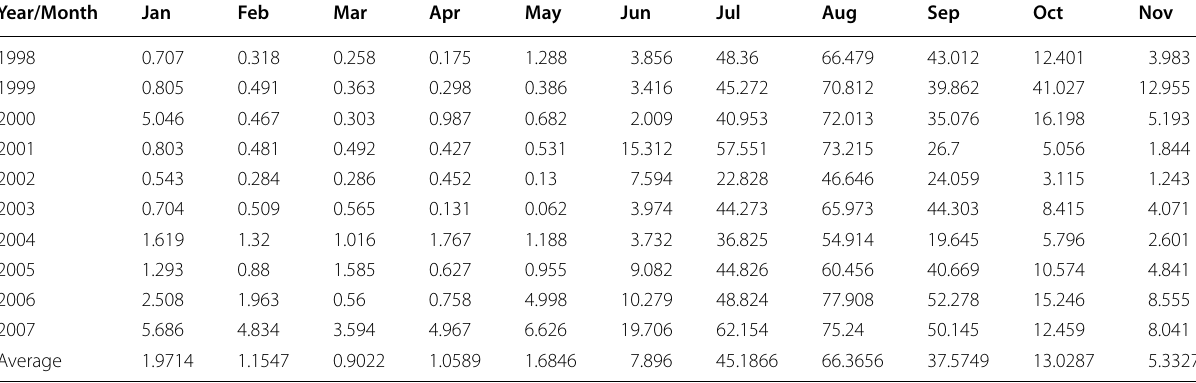
Table 2 Yearly/Monthly discharge flow data of the Rib River (Woldemariam 2004) Year/Month